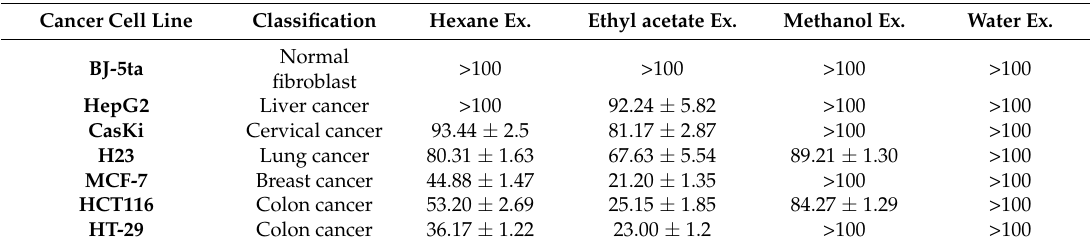
Table 1. The IC 50 ( µ g/mL) of PVLH different extracts on several cancer cell lines by the MTT assay after 72